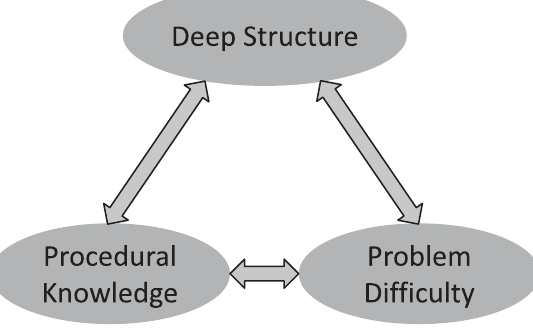
FIG. 3. The pillars of expert-novice differentiation.